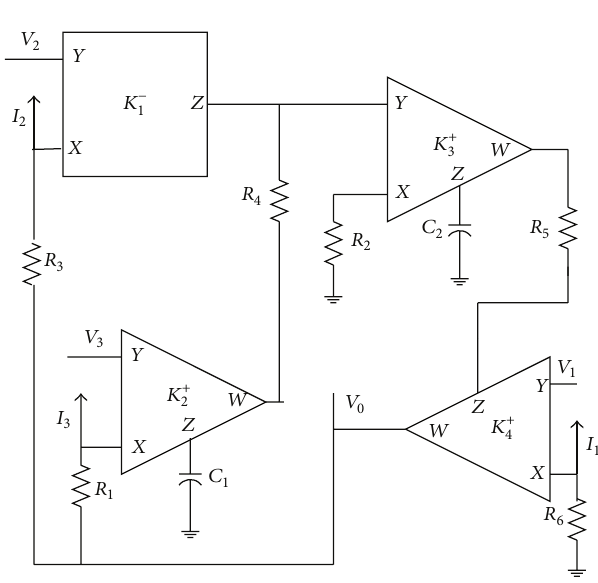
Figure 4: First derived